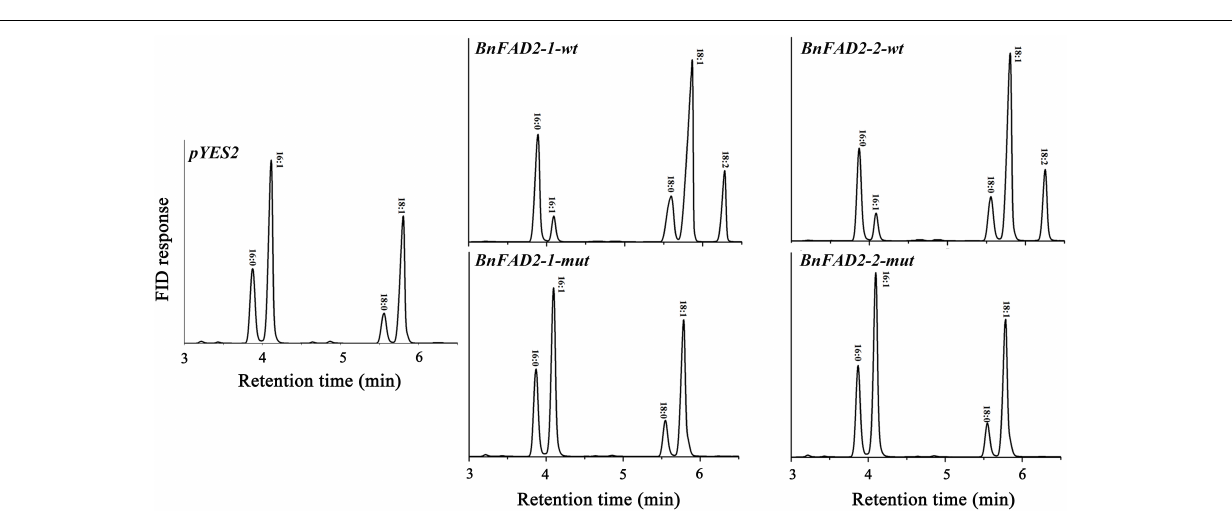
FIGURE 3 | Gas chromatograms showing the fatty acid profiles of BnFAD2- transformed yeast. Representative chromatograms highlighting the fatty acid compositions of yeast strains transformed with pYES2 , BnFAD2-1-wt , BnFAD2-1-mut , BnFAD2-2-wt , and BnFAD2-2-mut (top to bottom). The x axes represent retention time in minutes, while the y axes represent the detector (FID response). 16:0, palmitic acid; 16:1, palmitoleic acid; 18:0, stearic acid; 18:1, oleic